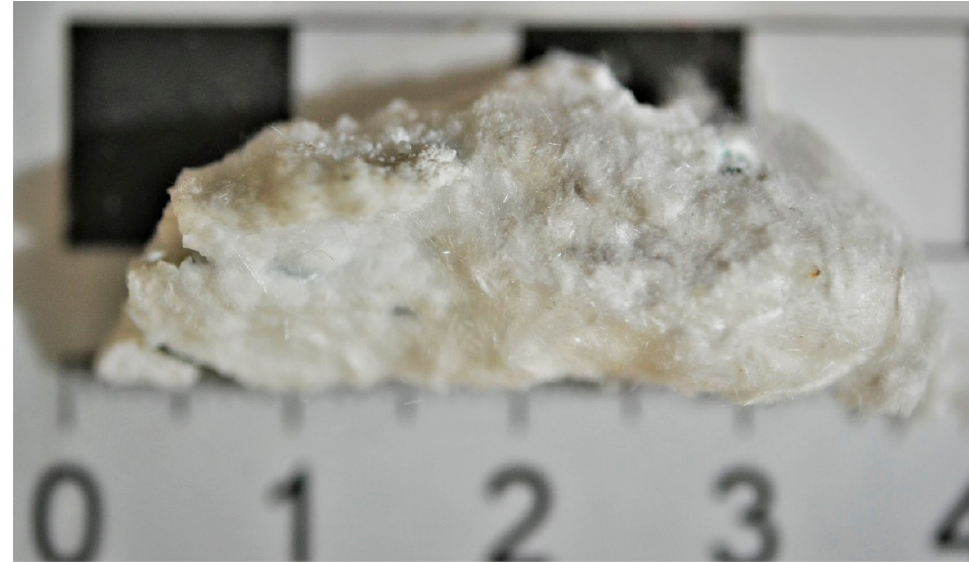
Figure 1. A stereomicroscopic image of the mordenite from Poona district, Maharashtra, India.